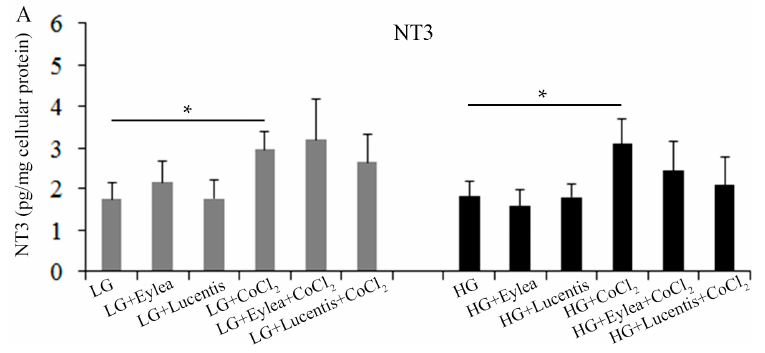
Figure 8. Cont. Figure 8. Cont